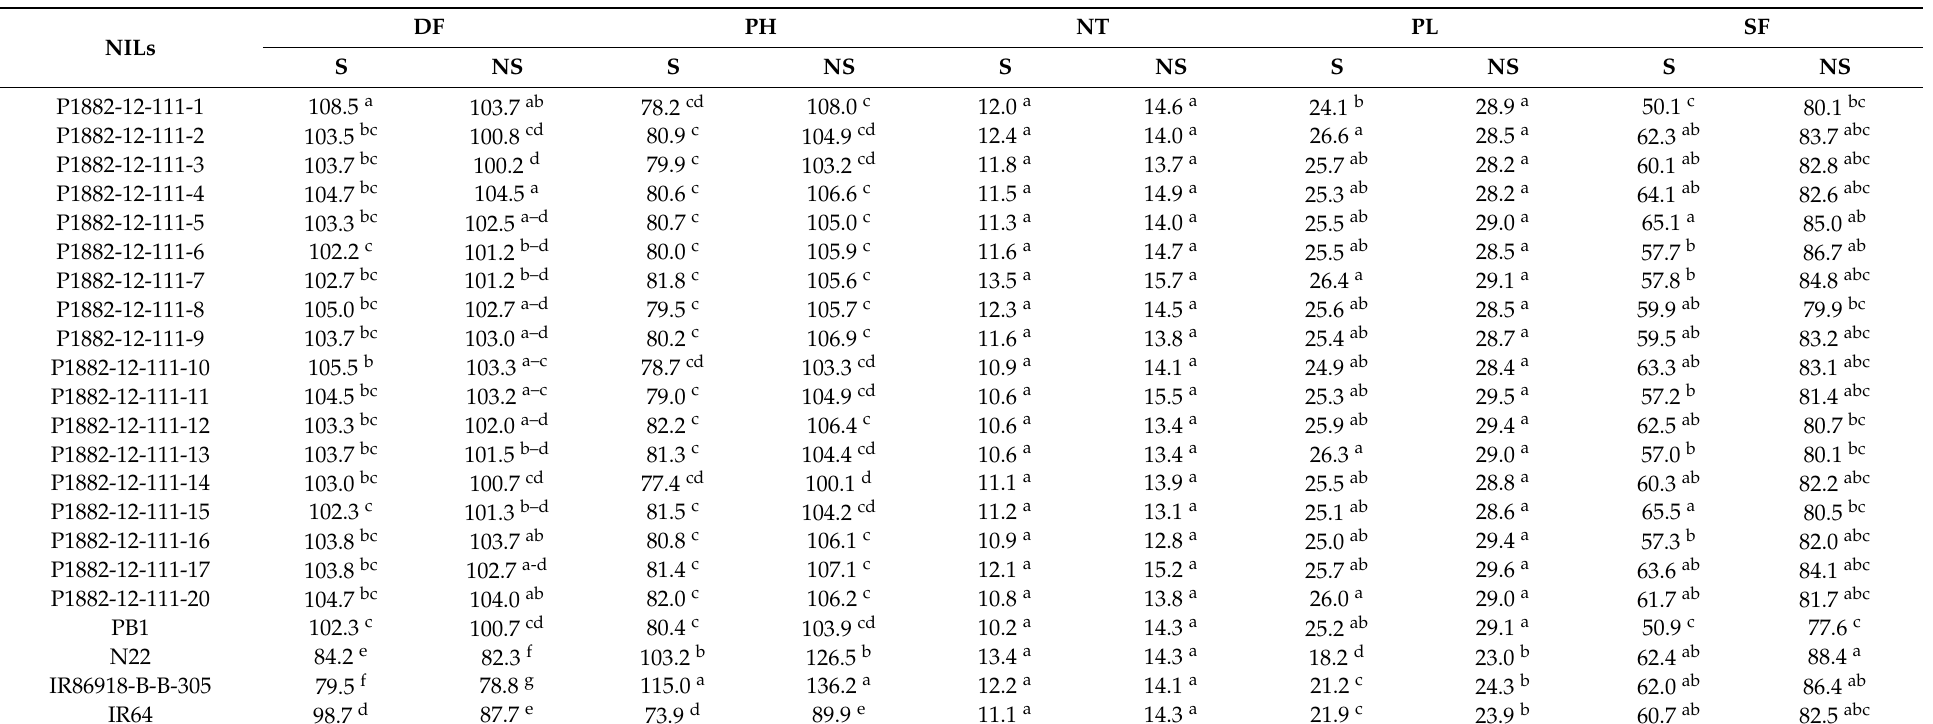
Table 4. Average agronomic performance of NILs, parents and checks under drought stressed (S) and unstressed (NS) conditions over three seasons.